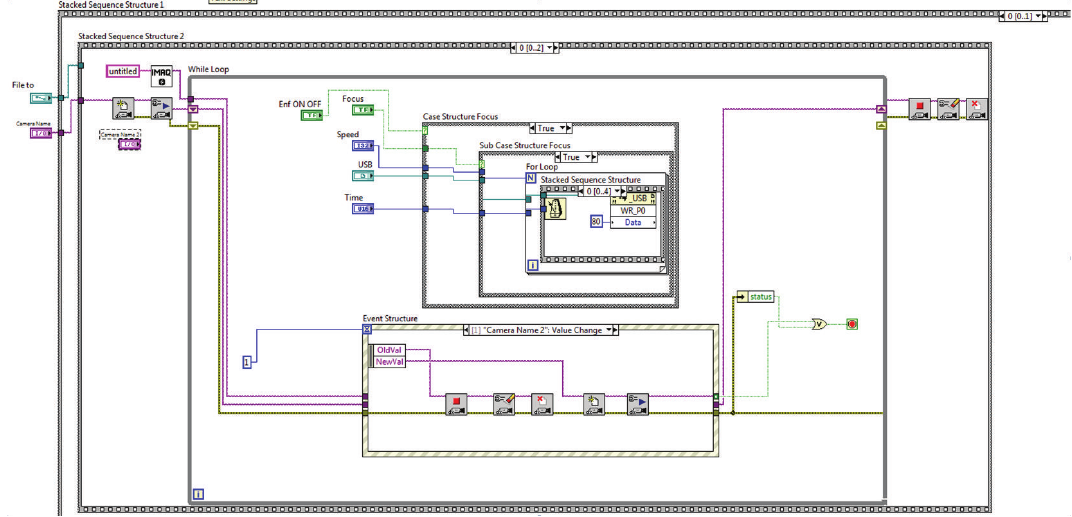
Figure 3: Digitizing sub-VI: image preview and focusing.